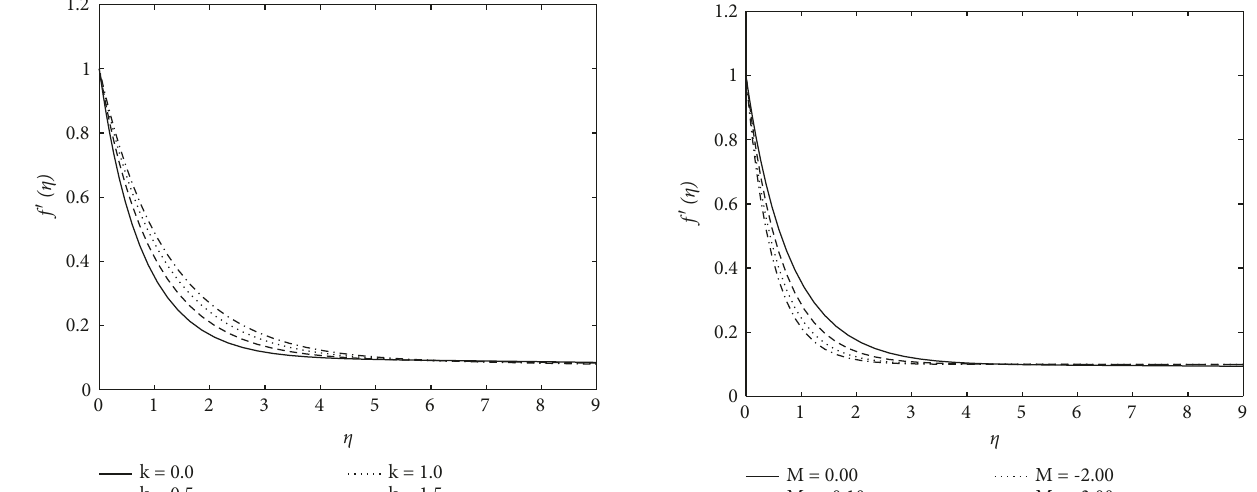
0 Figure 4: Change in the value of f